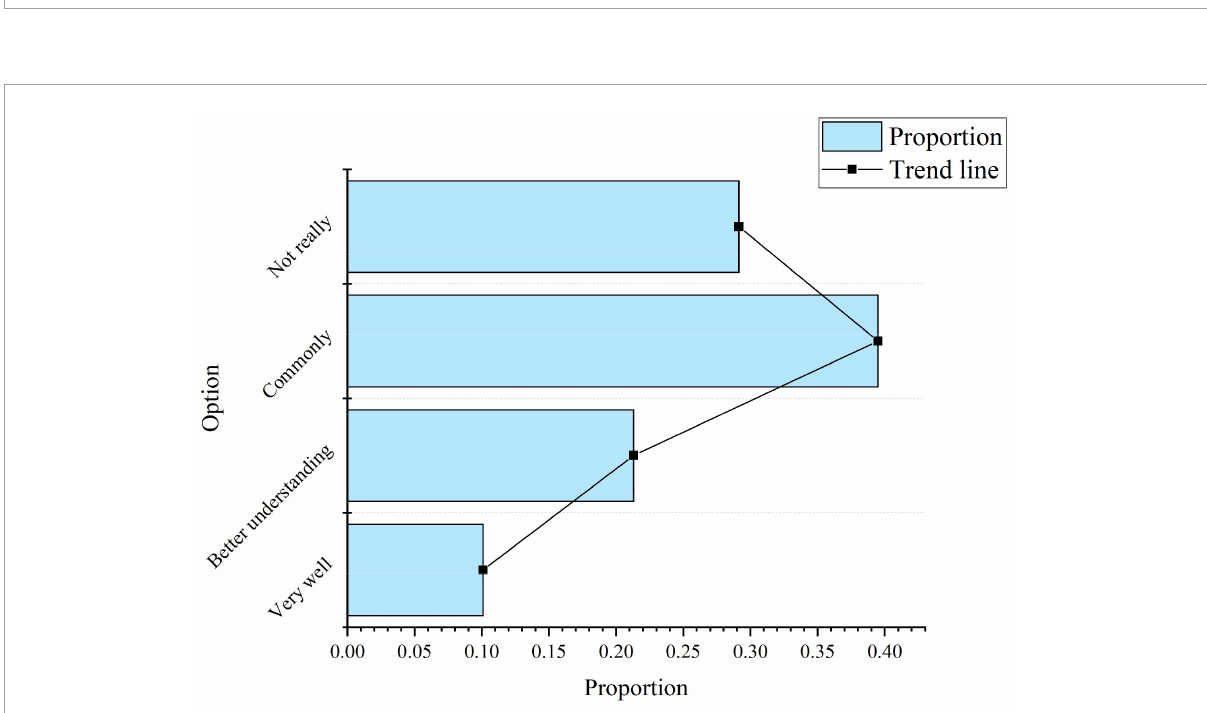
FIGURE3 Understanding of entrepreneurial